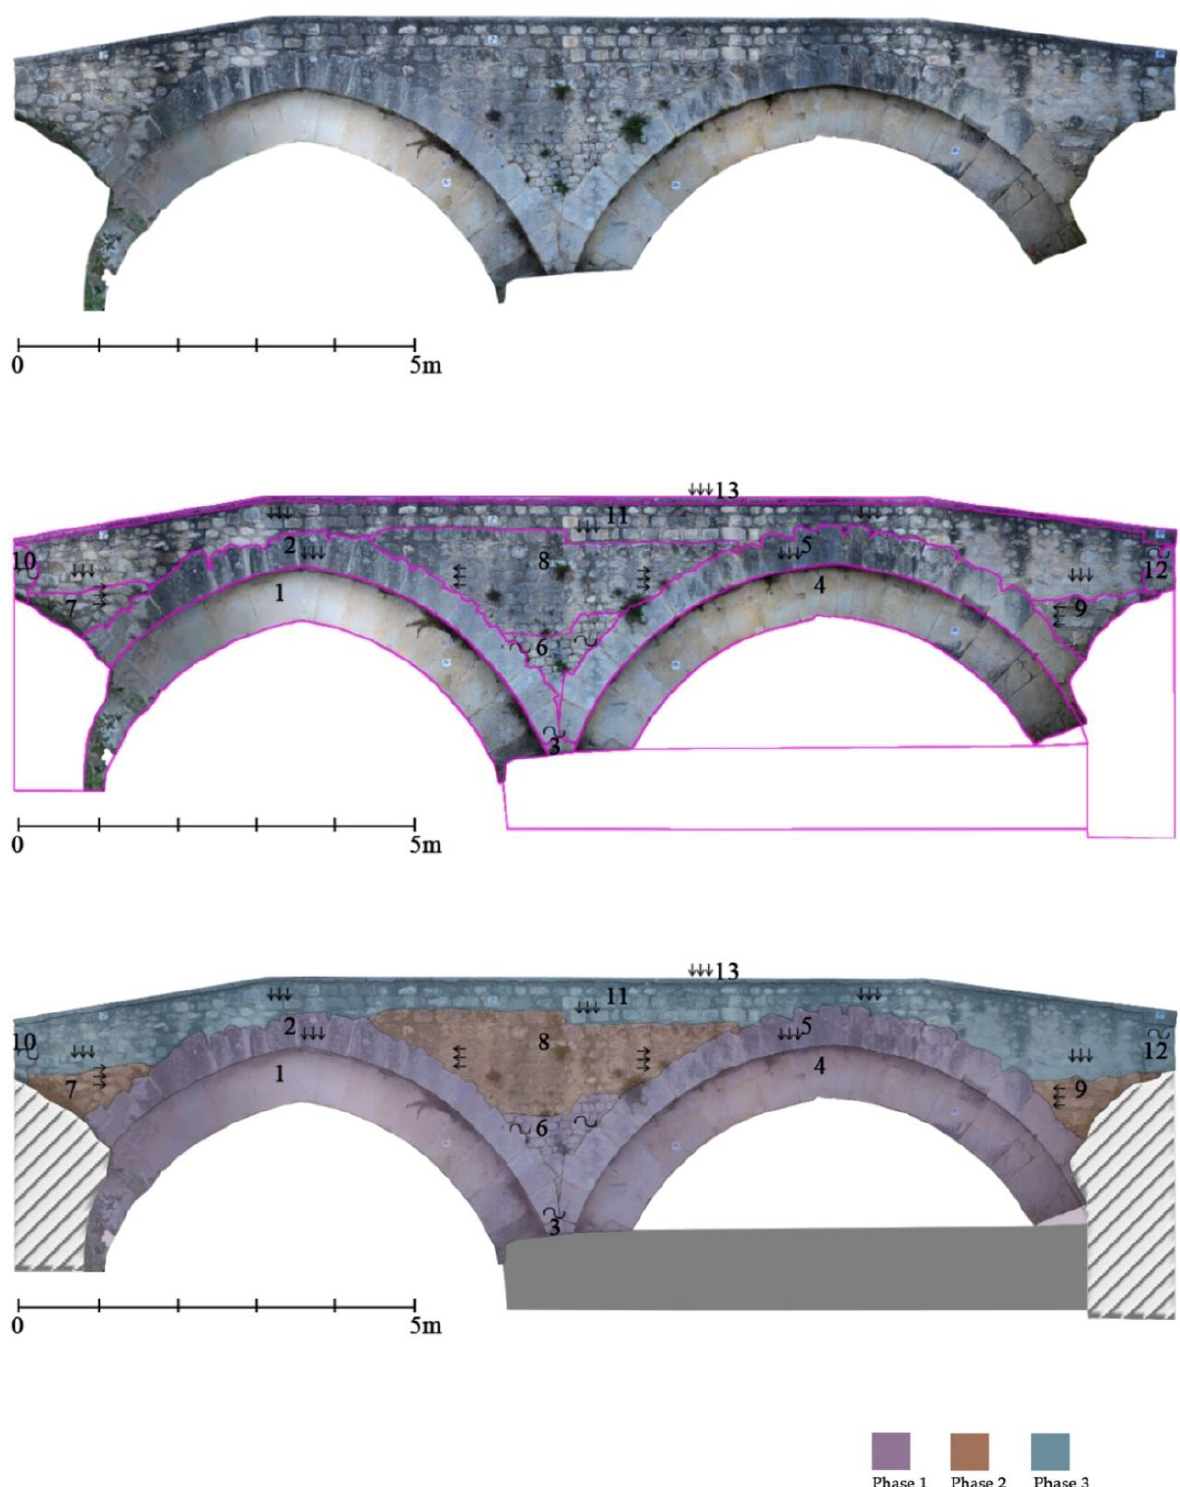
Figure 9. Stratigraphic analysis of the bridge’s southeast front (AA’) in the Cerro locality.